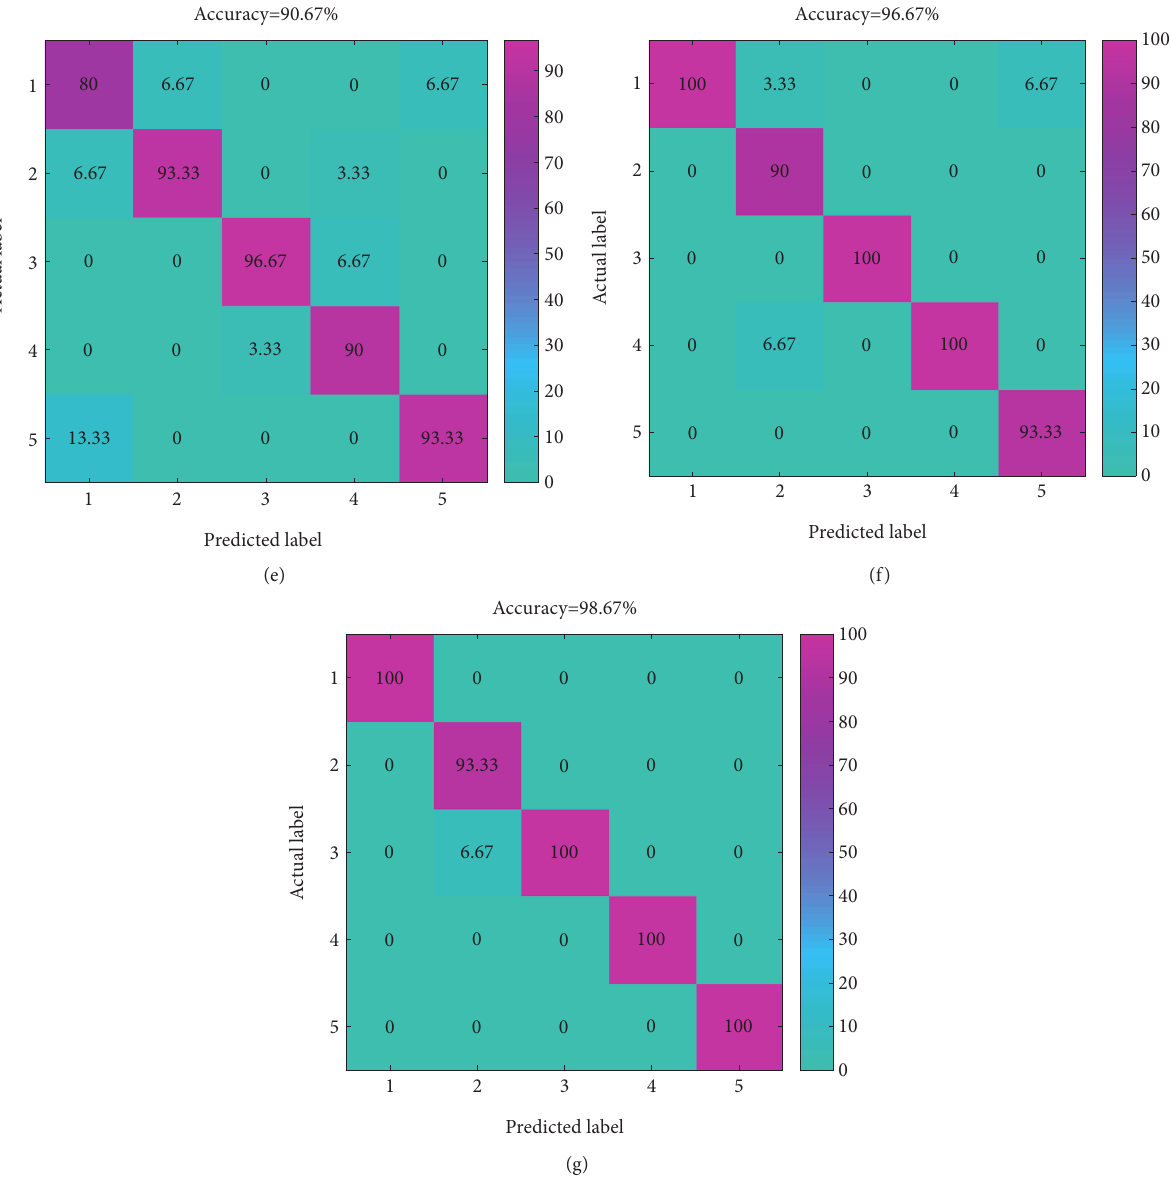
Figure 22: The confusion matrix of the seven feature extraction